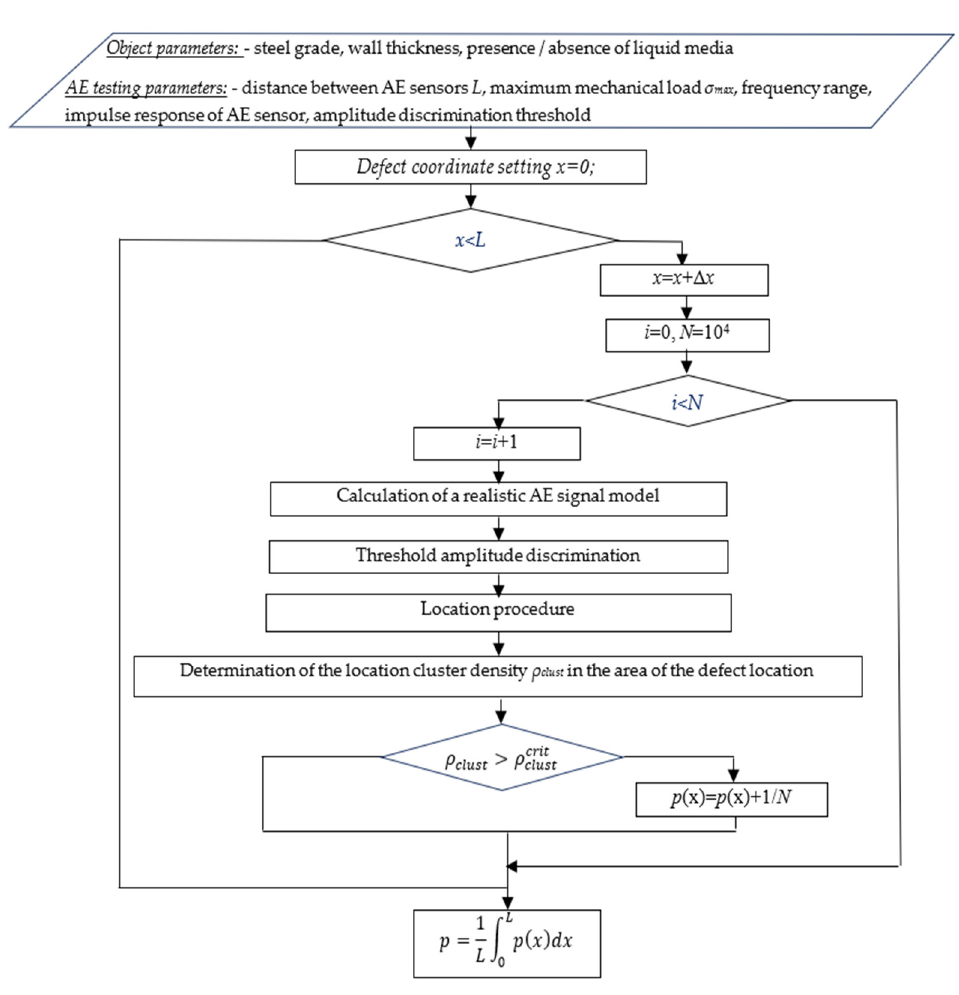
Figure 6. Flowchart of the algorithm for POD assessment. A defect is detected if the location cluster has reached the critical density ρ crit erwise, a type-II error occurs. Since the simulation is based on the probabilistic model